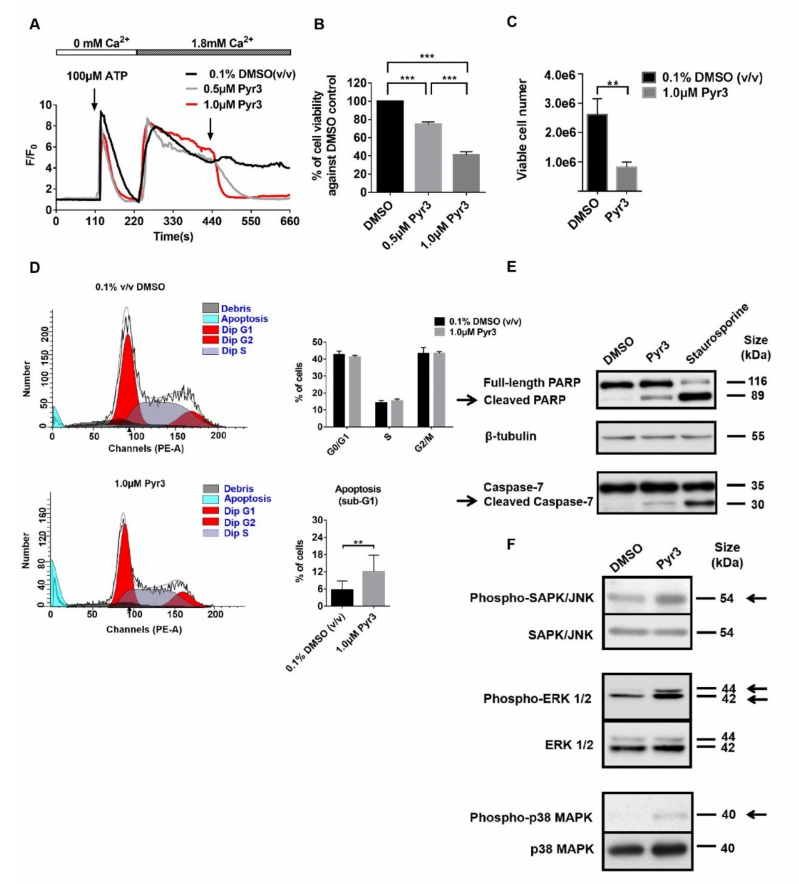
Figure 2. TRPC3 regulated calcium influx, proliferation and apoptosis of MDA-MB-231. ( A ) representative Ca 2 + imaging traces reflected changes in the level of cytosolic free calcium over time in MDA-MB-231. Average fluo-4 fluorescence intensity was transiently increased in response to 100 µ M ATP when external Ca 2 + was absent. Addition of external calcium (1.8 mM) led to an increase in fluorescence intensity; a marked decrease of the fluorescence intensity was observed when 0.5 / 1.0 µ M Pyr3 was applied. Our results showed that TRPC3 blocker Pyr3 abolished ATP-induced Ca 2 + influx in MDA-MB-231. F / F0: fluorescence (F) normalized to baseline fluorescence (F0). Traces of fluorescence intensity are average of at least three independent experiments, with 75–100 cells measured in total; ( B ) blocking TRPC3 by Pyr3 (0.5 / 1.0 µ M for 72 h) decreased the percentage of viable MDA-MB-231 cells in a concentration-dependent manner when compared to DMSO control as measured by an MTT assay. OD570 values of 0.1% DMSO ( v / v ) solvent control group was set as 100% of cell viability. Values are mean ± SEM ( n = 5). *** p < 0.001; ( C ) blocking TRPC3 by Pyr3 (1.0 µ M for 120 h) attenuated the proliferation of MDA-MB-231 as measured by trypan blue exclusion assay. Initial seeding number of MDA-MB-231 cells was 2 × 10 5 and viable cells were counted after 5-day DMSO / Pyr3 treatment. Values are mean ± SEM ( n = 3). ** p < 0.01; ( D ) blocking TRPC3 by Pyr3 (1.0 µ M for 120 h) increased DNA damage with accumulation of cells in the sub-G1 phase but did not a ff ect cell cycle distribution of viable cells as measured by cell cycle analysis. Values are mean ± SEM ( n = 3). ** p < 0.01; ( E ) representative Western blots showing that levels of cleaved caspase-7 and cleaved PARP were increased in Pyr3-treated MDA-MB-231 cells when compared to DMSO control group. MDA-MB-231 cells treated with 0.1 µ M staurosporine (apoptosis inducer) for 24 h was used as positive control for detection of bands of cleaved caspase-7 and PARP proteins. β -tubulin was used as an internal control. Results showed that blocking TRPC3 by Pyr3 (1.0 µ M for 72 h) induced apoptosis of MDA-MB-231 in a caspase-dependent manner; ( F ) representative Western blots showing that levels of phosphorylated p38 MAPK, ERK1 / 2 and JNK were all increased in Pyr3-treated MDA-MB-231 cells. Total p38 MAPK, ERK1 / 2 and JNK were also detected. Results showed that blocking TRPC3 by Pyr3 (1.0 µ M for 72 h) activated MAPK pathways in MDA-MB-231